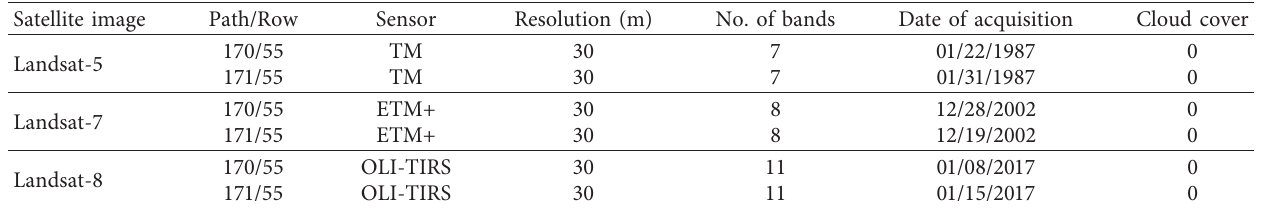
Figure 2: Mean annual temperature and rainfall recorded in (a) Tinishu Meti (1987–2017) and (b) Ermichi (1987–2017) Metrological stations. Table 1: Satellite images used for LULC change analysis and their characteristics.